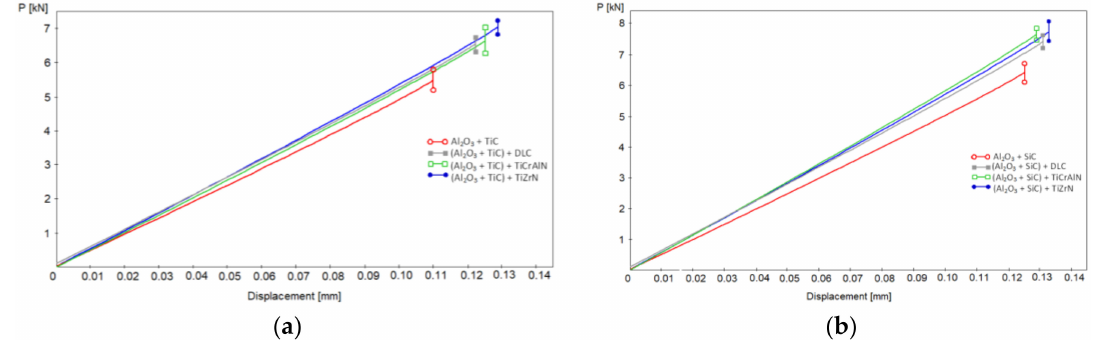
Figure 9. The diagrams of the applied load and displacement of the punch before the destruction of the cutting inserts with the different coatings: ( a ) Al 2 O 3 + TiC ceramic; ( b ) Al 2 O 3 + SiC